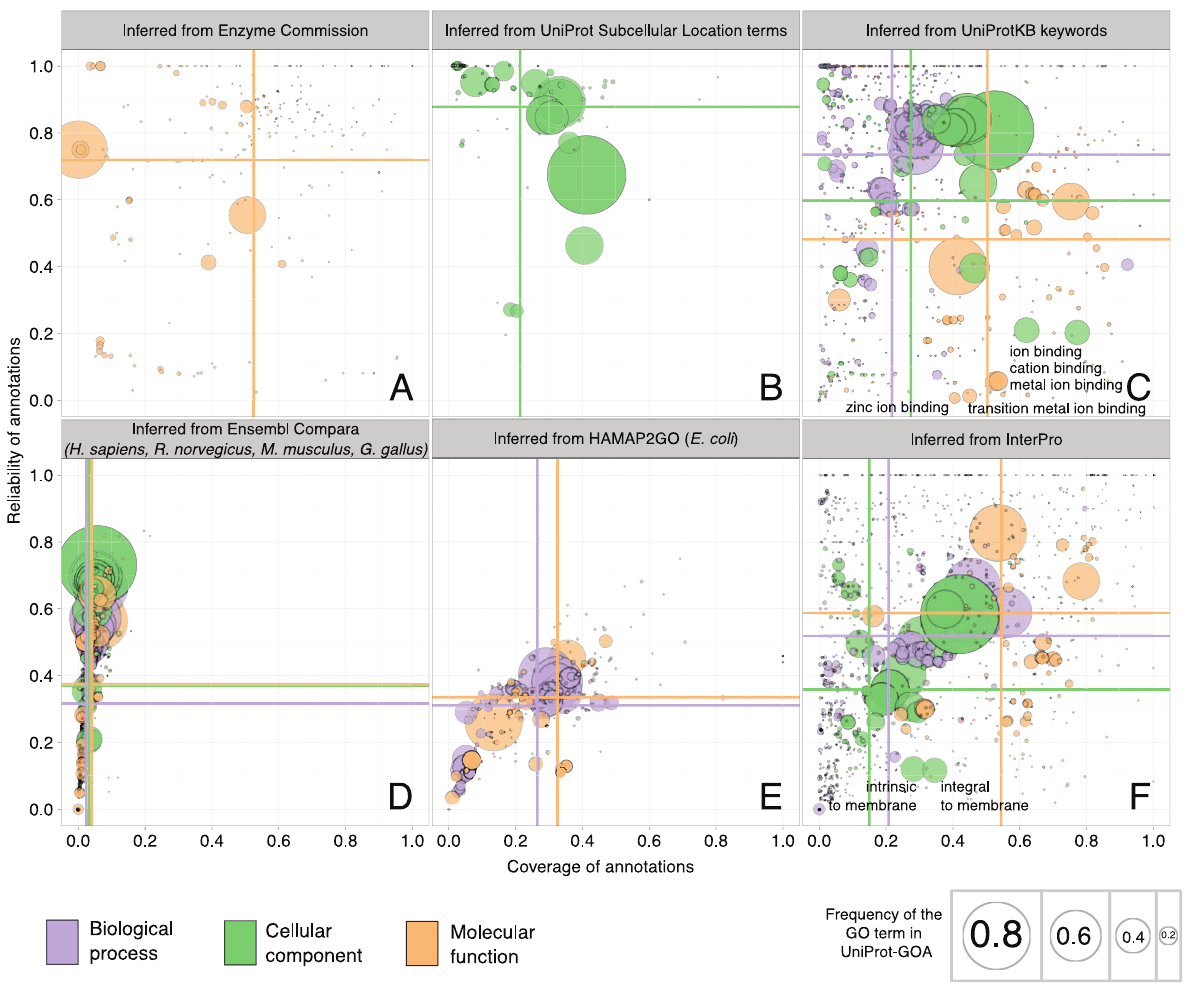
Figure 6. The quality of the 16-01-2008 UniProt-GOA release, evaluated by the 11-01-2011 UniProt-GOA release. Each reference code is evaluated separately: (A) Inferred from Enzyme Commission, (B) Inferred from UniProt Subcellular Location terms, (C) Inferred from UniProtKB keywords, (D) Inferred from Ensembl Compara, (E) Inferred from HAMAP2GO, and (F) Inferred from InterPro. The 12 model organisms included in the analysis are Homo sapiens, Mus musculus, Rattus norvegicus, Caenorhabditis elegans, Drosophila melanogaster, Arabidopsis thaliana, Gallus gallus, Danio rerio, Dictyostelium discoideum, Saccharomyces cerevisiae, Schizosaccharomyces pombe , and Escherichia coli K-12. The ontology is denoted by the color of the disc, while the area of the disc reflects the frequency of the GO term in the 16-01-2008 UniProt-GOA release. The colored lines correspond to the mean values for the respective axes. To be visualized in this plot, a GO term needs to have assigned at least 10 electronic annotations in the 16- 01-2008 UniProt-GOA release and at least 10 experimental annotations in the 11-01-2011 UniProt-GOA release.